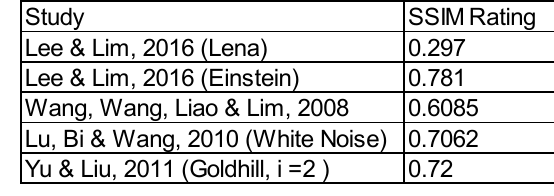
Table 4: Compiled SSIM indices for salt-and-pepper noise from different studies